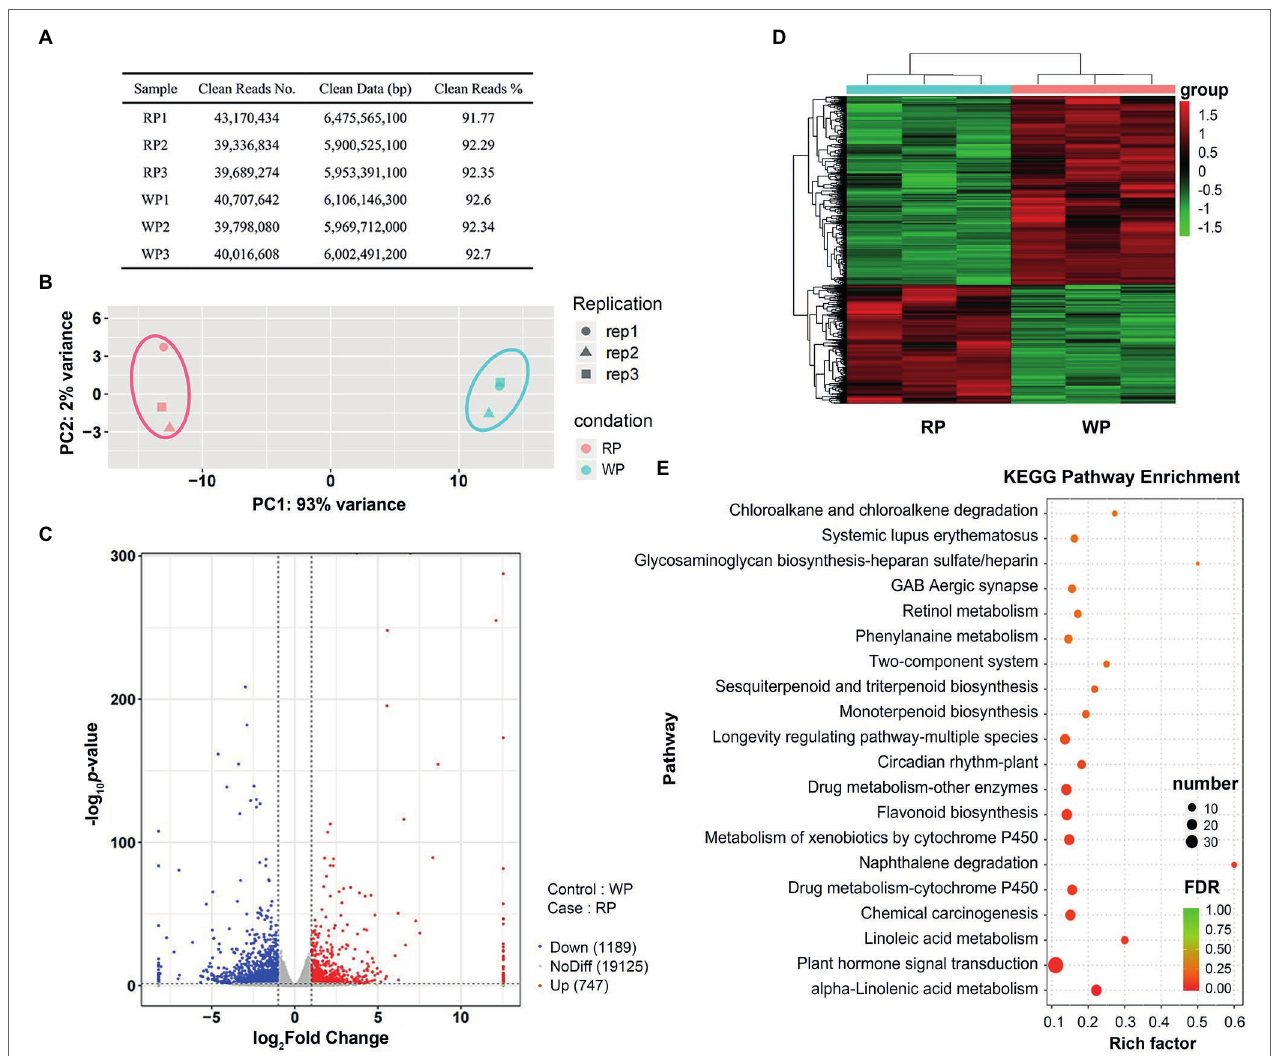
FIGURE 3 | The RNA-seq expression profiles of Prunus tomentosa in mature stage. (A) Statistics of sequencing data filtering in RP and WP samples; (B) Principal component analysis (PCA) of genes identified in P. tomentosa fruit at mature stage; (C) Volcano plots of the gene transcription profile in WP and RP libraries. Red dots represent the upregulated genes, blue dots represent the downregulated genes; (D) Heatmap of all differential expression genes (DEG: |log 2 Fold Change| > 1 and value of p <0.05). Color indicates the expression level of each gene, from green (low) to red (high); (E) KEGG enrichment analysis with the top 20 KEGG pathways in the DEGs in RP vs. WP